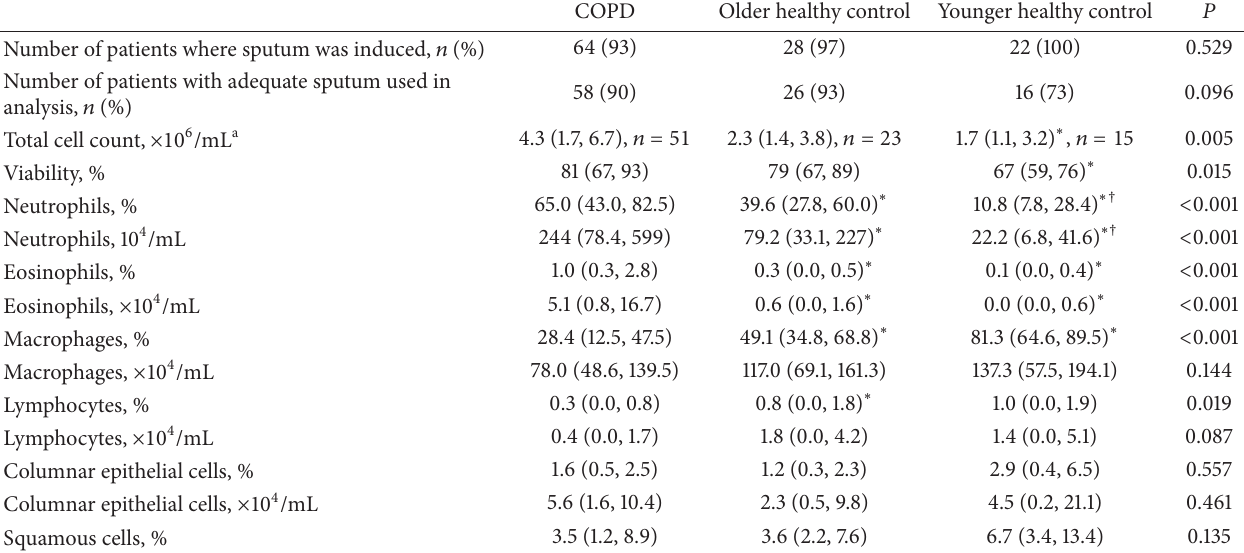
Table 2: Airway inflammation data. All data are median (q1, q3) unless stated. COPD Older healthy